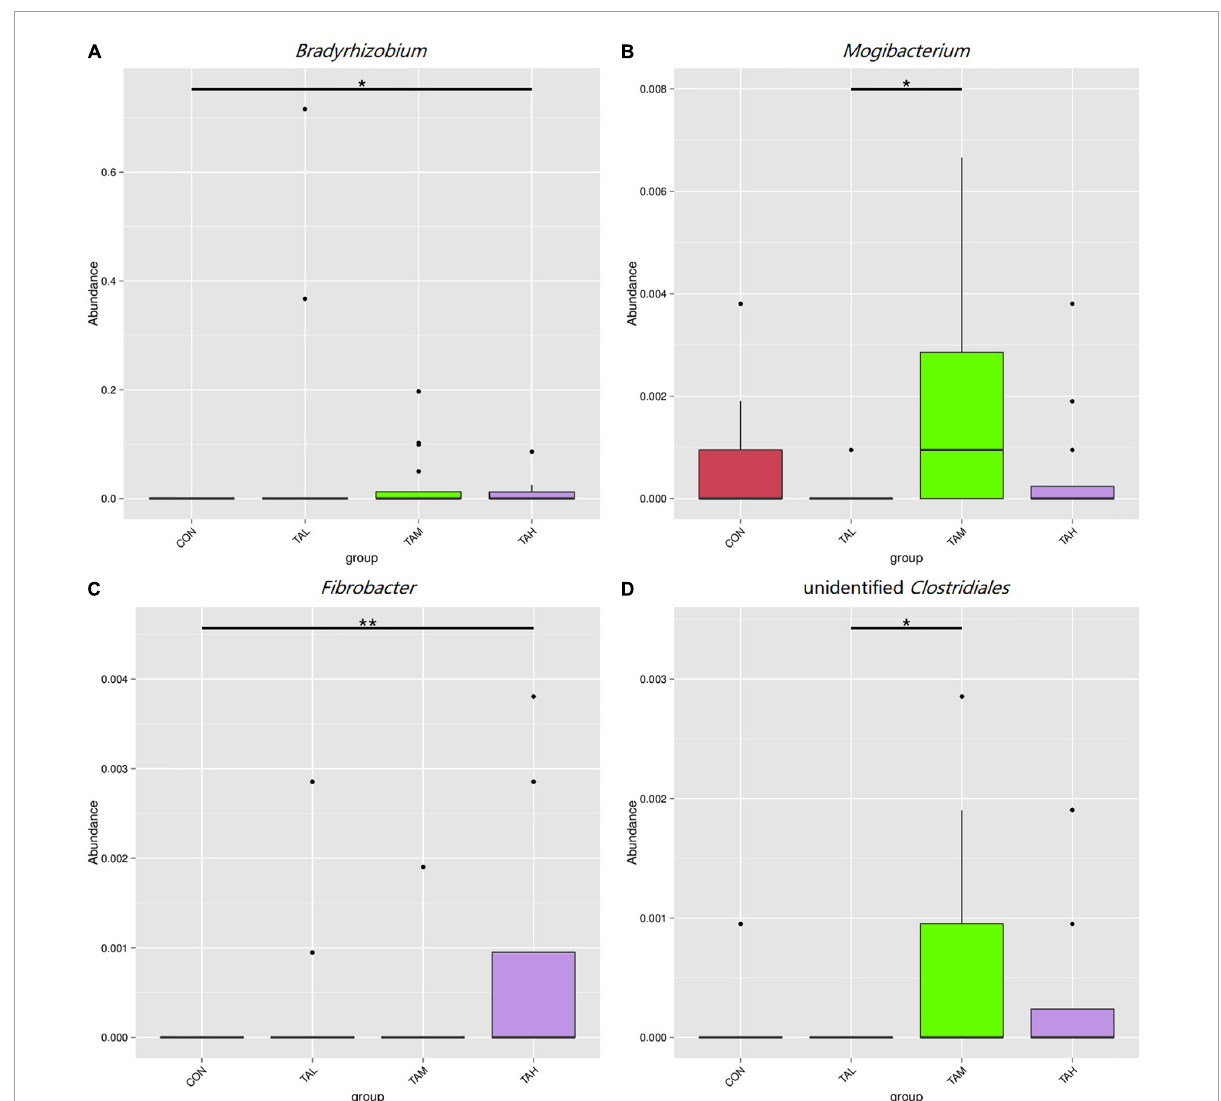
FIGURE3 Differential bacterial genera in the rumen fluid across the four treatments. (A) Bradyrhizobium . (B) Mogibacterium . (C) Fibrobacter . (D) Unidentified Clostridiales . *Means that the difference between two treatments was significant ( P < 0 . 05). **Means that the difference between two treatments was highly significant ( P < 0 .